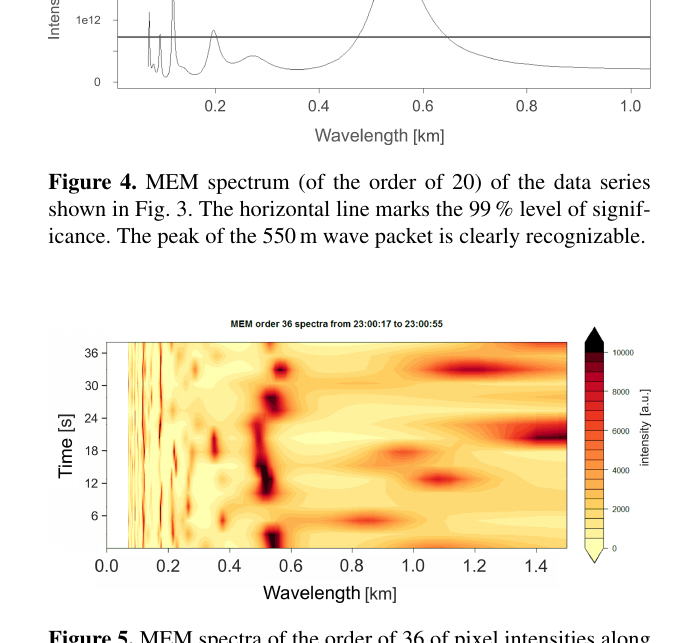
Figure 5. MEM spectra of the order of 36 of pixel intensities along the abovementioned cross section (its position is indicated by the black line in Fig. 2b) in every image taken between 23:00:17 and 23:00:55UTC. The signature of the 550m wave packet is found by the MEM nearly the entire